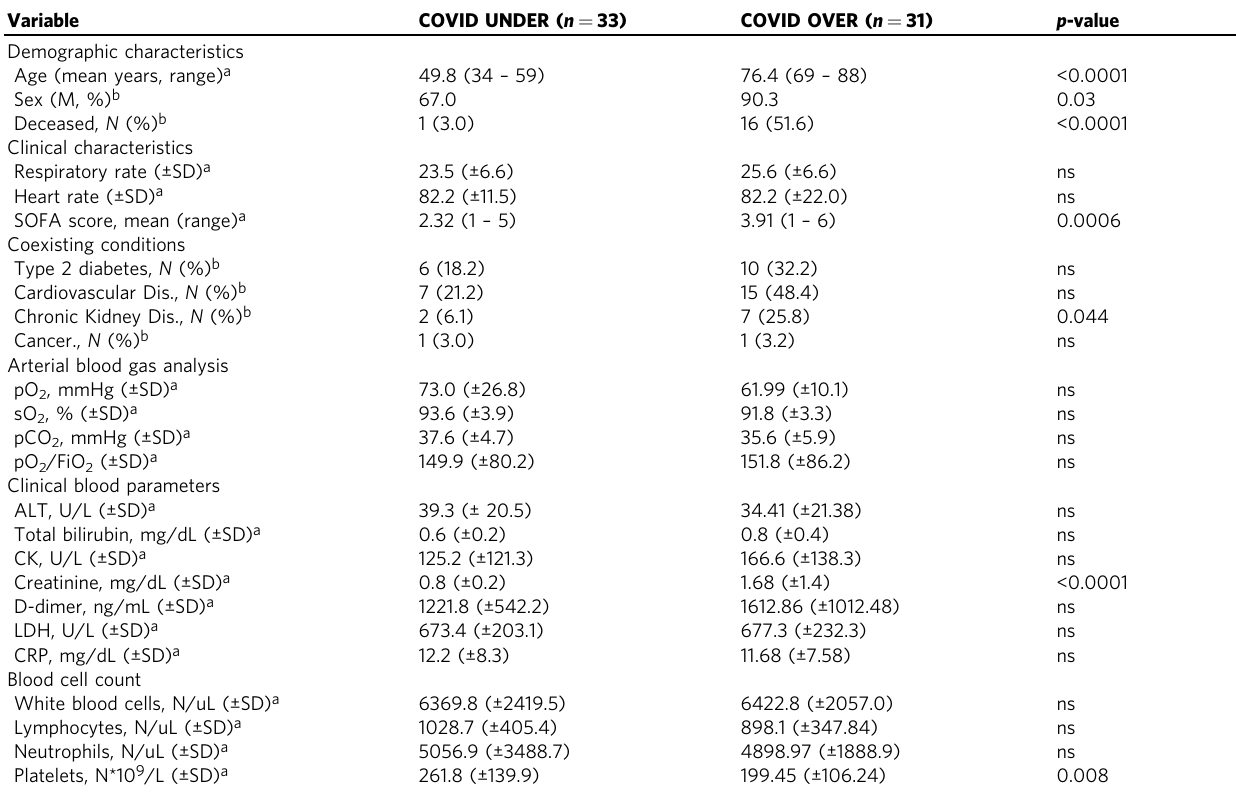
Table 1 Demographic and clinical characteristics of COVID-19 patients. Variable COVID UNDER ( n = 33) COVID OVER ( n = 31) p